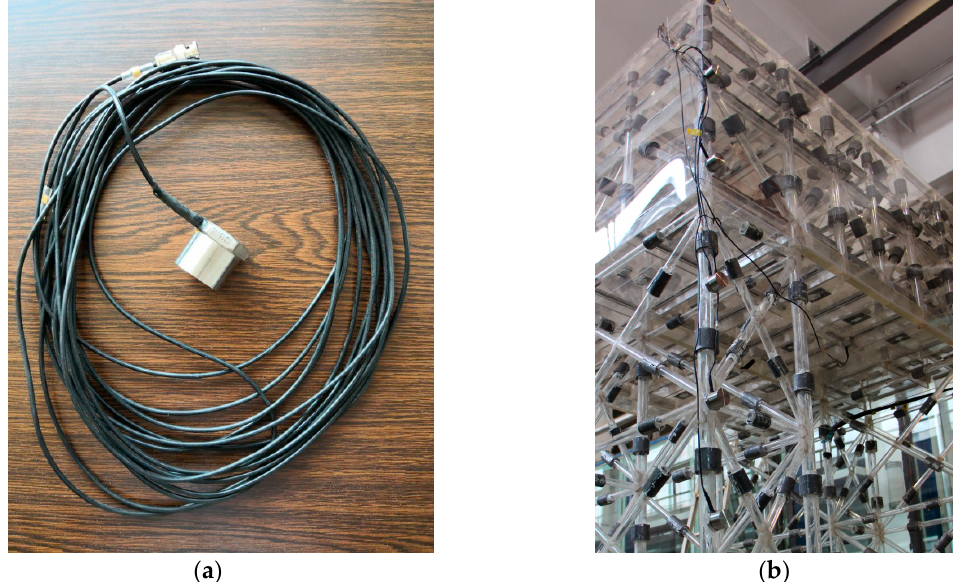
Figure 4. The experimental layout of acceleration sensors. ( a ) Acceleration sensor; ( b ) Acceleration sensors on the platform.